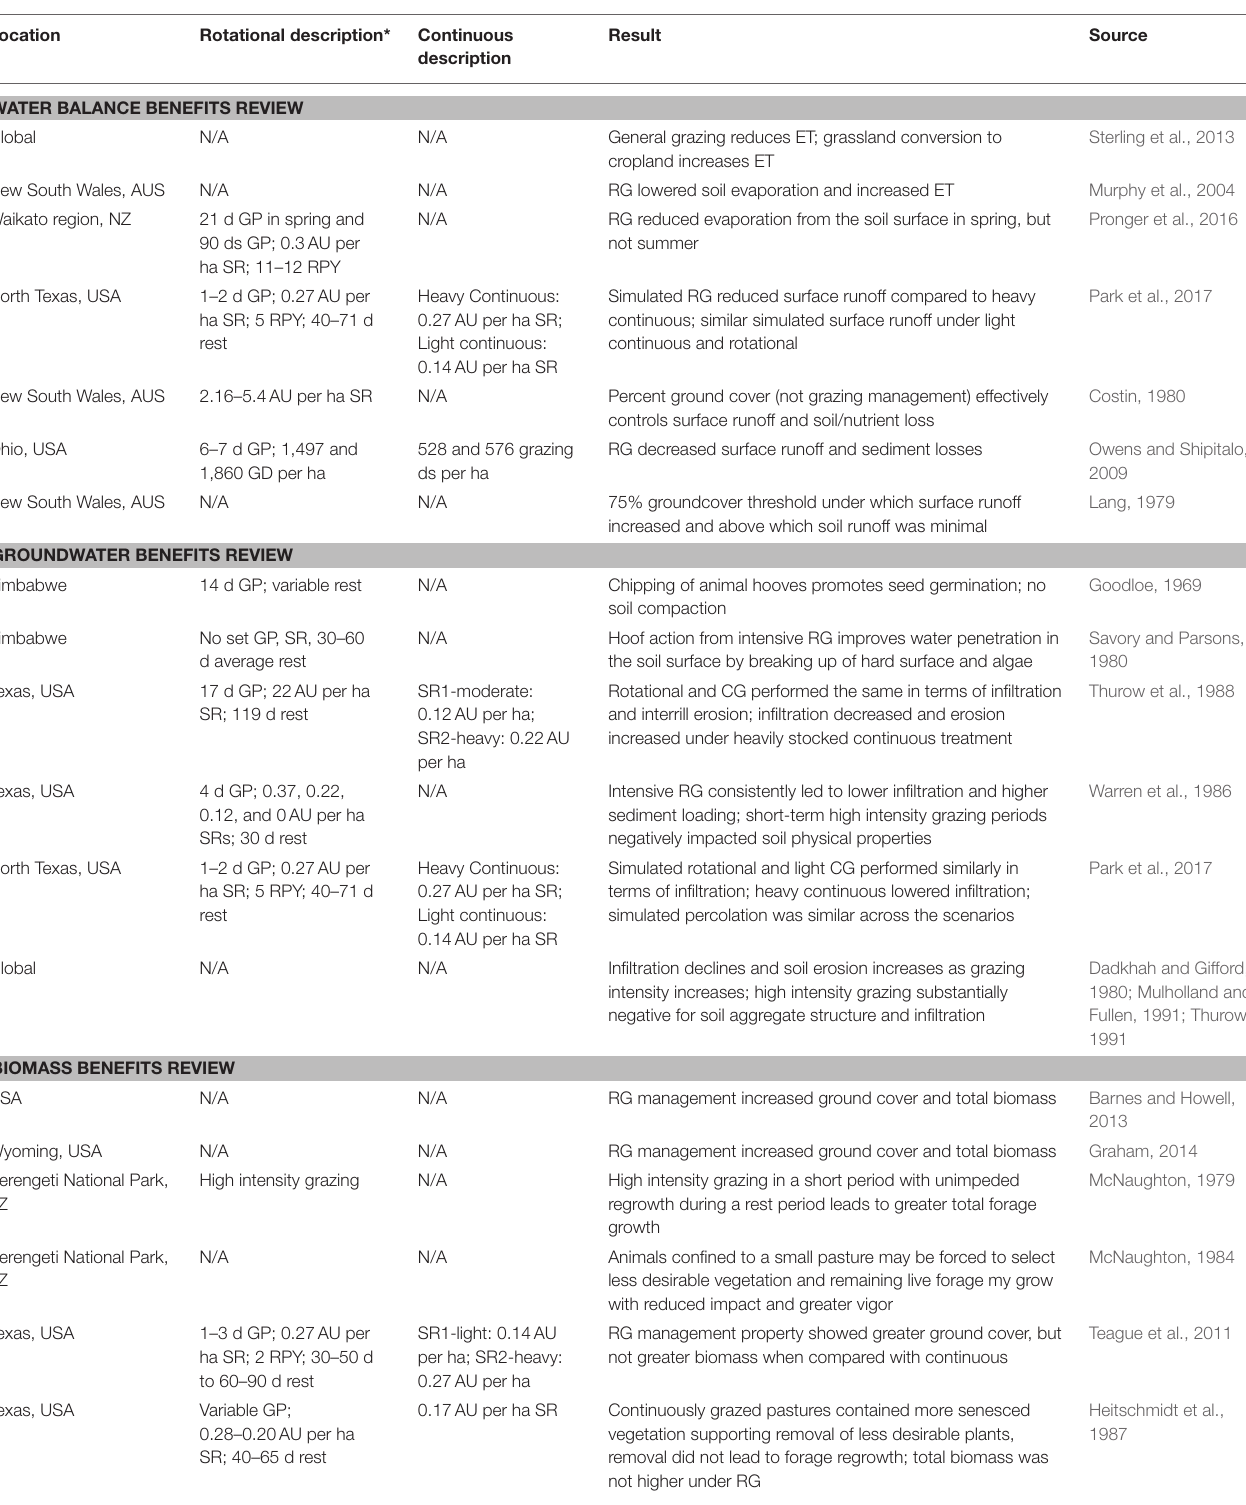
TABLE 1 | Summary of literature reviewed for this study, broken out by primary benefit examined (if a study examines multiple relevant benefits, it will appear more than once).